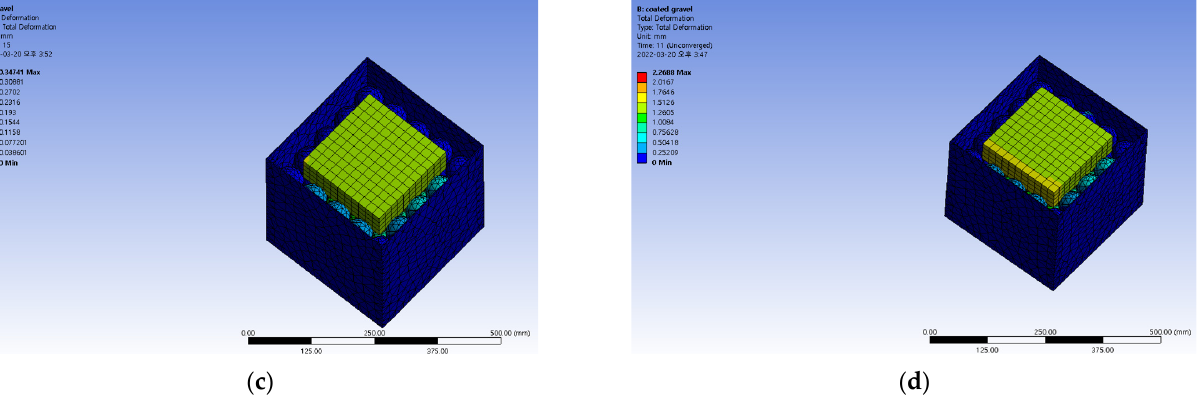
Figure 7. Static numerical analysis examples (250 mm): ( a ) ballast modeling, ( b ) load conditions and boundary conditions, ( c ) normal ballast (displacement), ( d ) coated ballast (displacement).